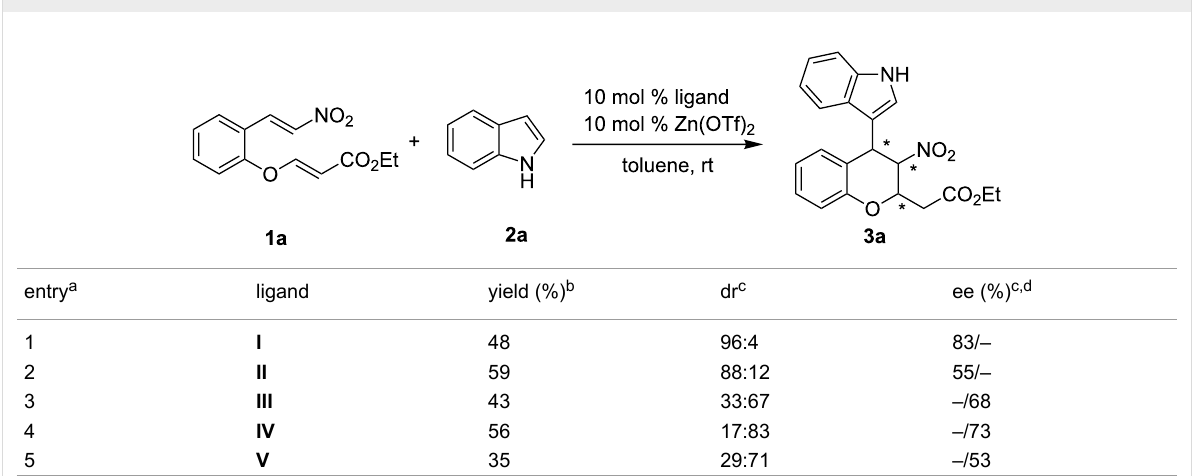
Table 1: Effect of ligands on the asymmetric tandem Friedel–Crafts alkylation/Michael addition reaction.